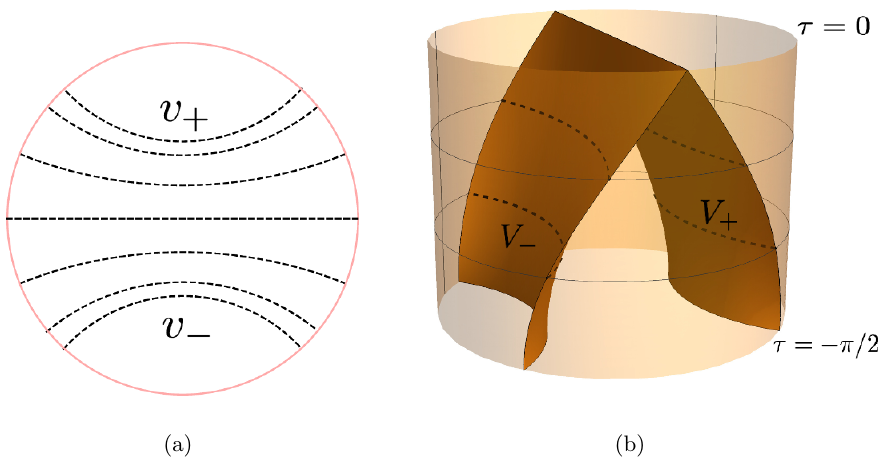
Figure 2 . Maximally extended BTZ black hole in global coordinates. (a) Projection of surfaces V (cid:6) onto equal time slices in di(cid:11)erent moments of global time. The dashed lines are identi(cid:12)ed. (b) 3D plot of the BTZ black hole identi(cid:12)cation surfaces V (cid:6) between (cid:28) = (cid:0) (cid:25)